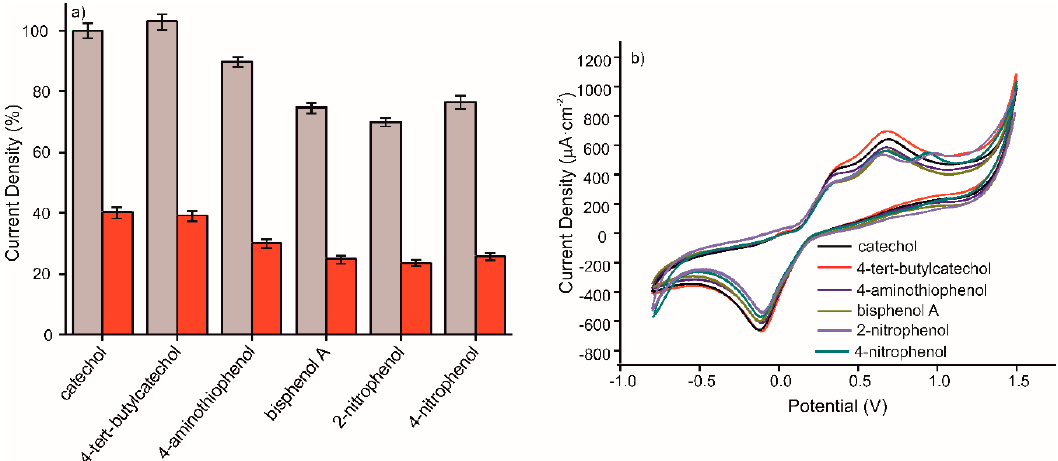
Figure 6. ( a ) Percentage of CV anodic peak value offered by MIP CS-MWCNT/AuNP nanocomposite/BDD sensor in black and NIP CS-MWCNT/AuNP nanocomposite/BDD sensor in red